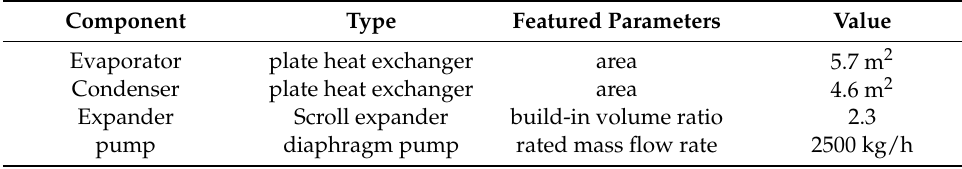
Table 1. The main features of the ORC